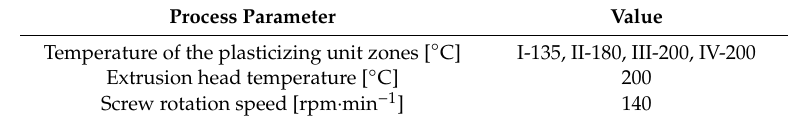
Table 2. Extrusion parameters used to prepare granulate.